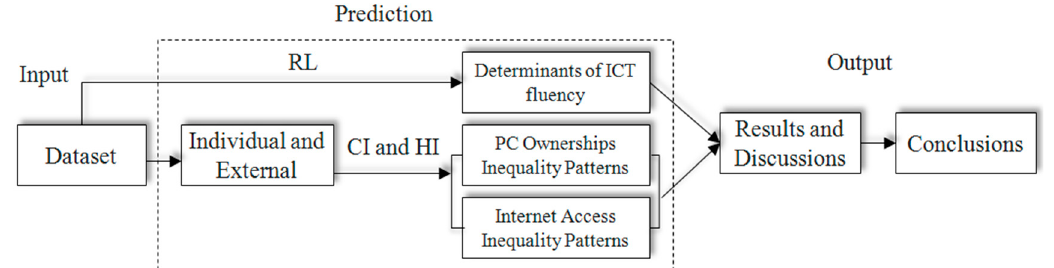
Figure 2. Data analysis and computation procedure.